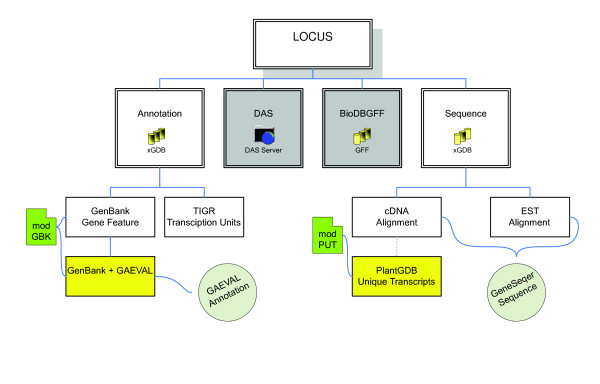
A partial representation of the object model for DSOs being used at AtGDB. Customized features derived from distribution objects are shown in yellow. Solid lines represent object inheritance. The dashed line connecting the PlantGDB Unique Transcripts feature represents instantiation of the cDNA DSO. Grey objects represent federated adaptors to external resources. DSO, data source object.